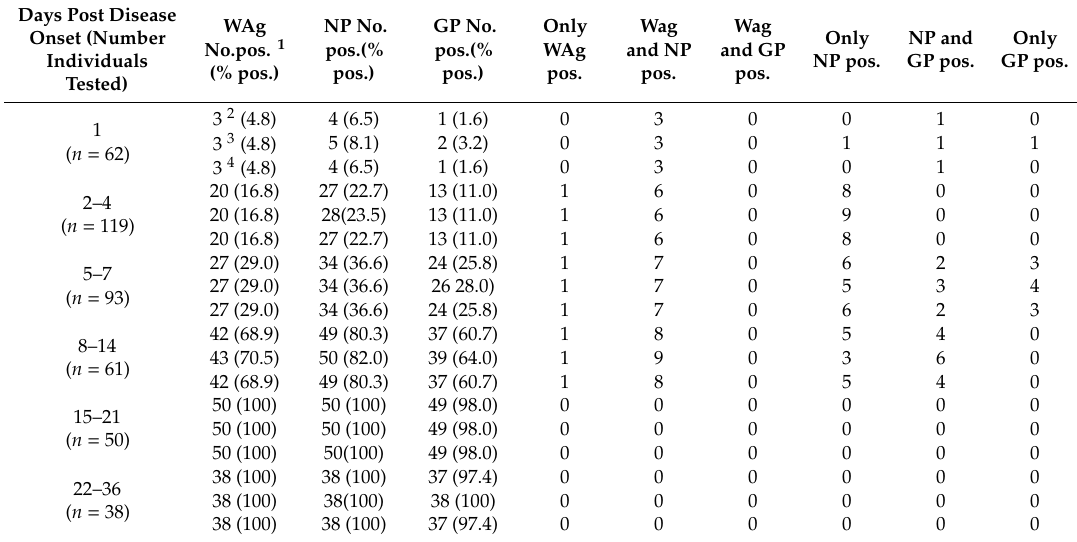
Table 3. Results of a whole antigen (WAg), nucleocapsid (NP), and glycoprotein (GP) indirect ELISAs for the detection of IgG antibody in 423 Ebola disease cases bled at di ff erent times post disease onset. Days Post Disease Onset (Number Individuals